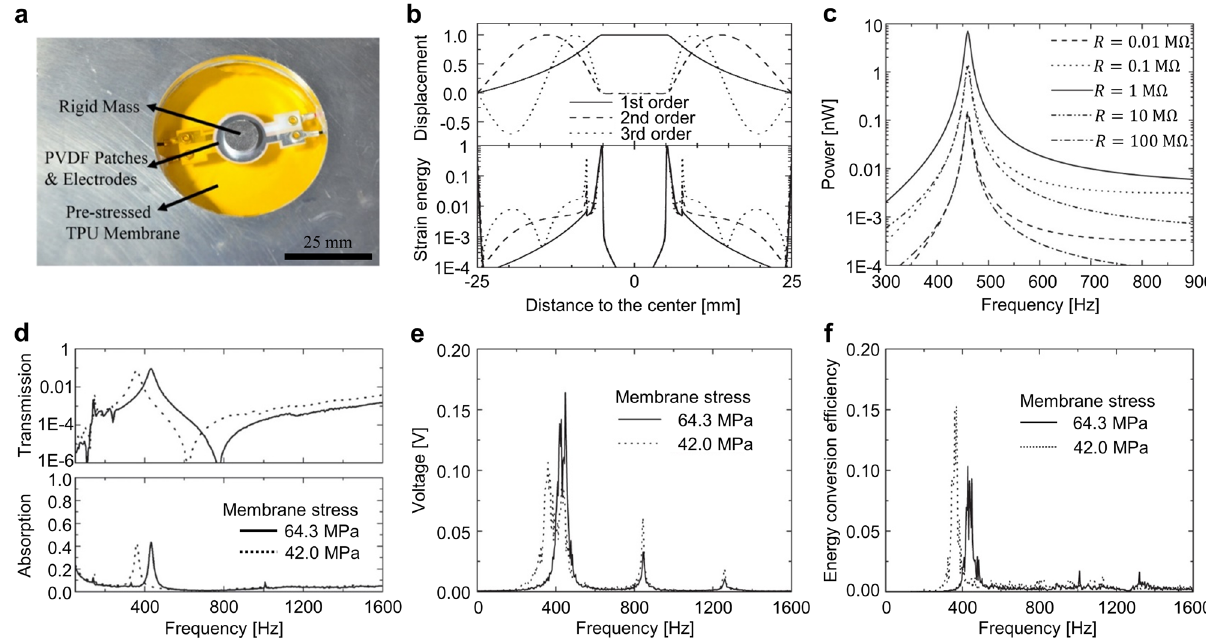
Fig. 2 Membrane-type acoustic metamaterial (MM) for energy harvesting. a Proposed locally resonant acoustic MM system that uses a fl exible piezoelectric material (polyvinylidene fl uoride fi lm (PVDF)) and a thermoplastic polyurethane (TPU) membrane with additional mass. b Displacement and strain energy of the fi rst three-order mode shapes along the central line of the MM. c Energy-dissipation behavior by the different resistors. The output power diminishes as the resistance increases. d Transmission and absorption spectra vs frequency with varying membrane stresses. e , f Output voltage and energy-conversion ef fi ciency from acoustic MMs with different membrane stresses 62 . Reprinted with permission from ref. 62